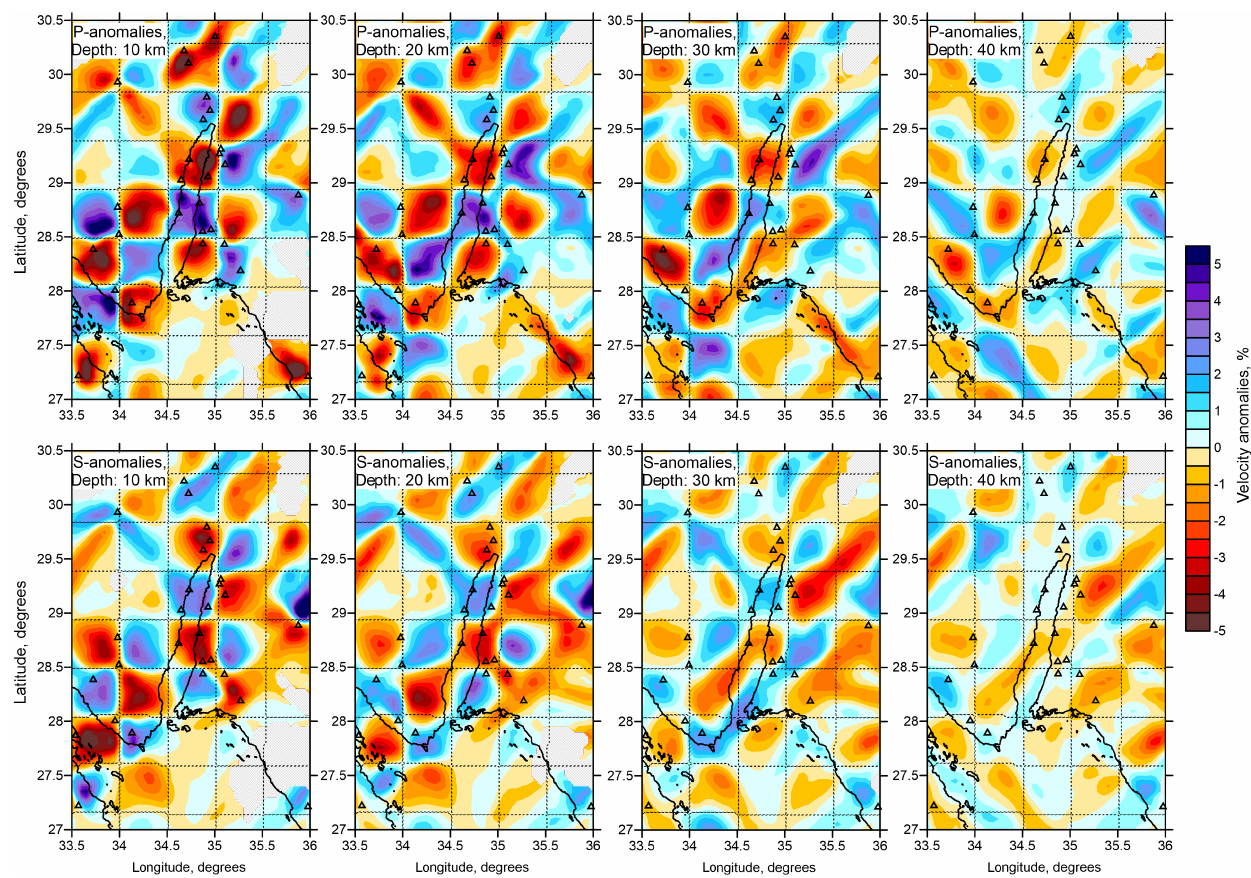
Figure 4. Results of the checkerboard test with the model unchanged with depth for P and S velocity anomalies. The recovered velocity anomalies are presented in four depth sections. Dotted lines indicate the configurations of the “true” synthetic patterns. Triangles depict seismic